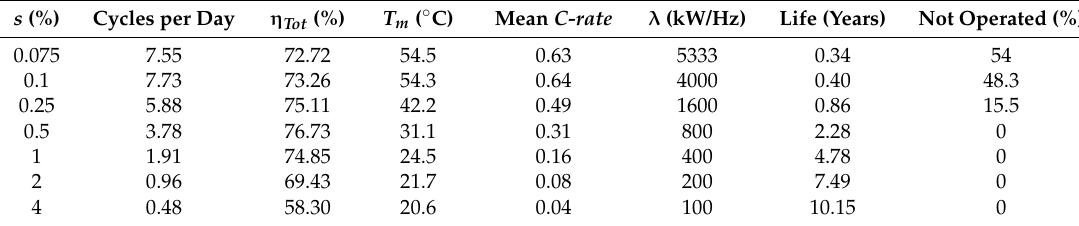
Table 7. PFC results: C-rate = 4C, T 0 = 20 ◦